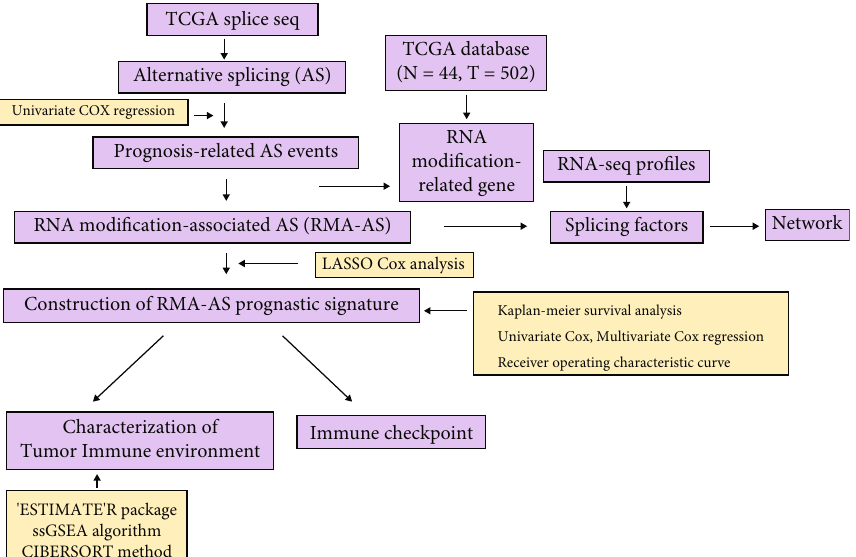
Figure 1: Flow chart of the comprehensive analysis